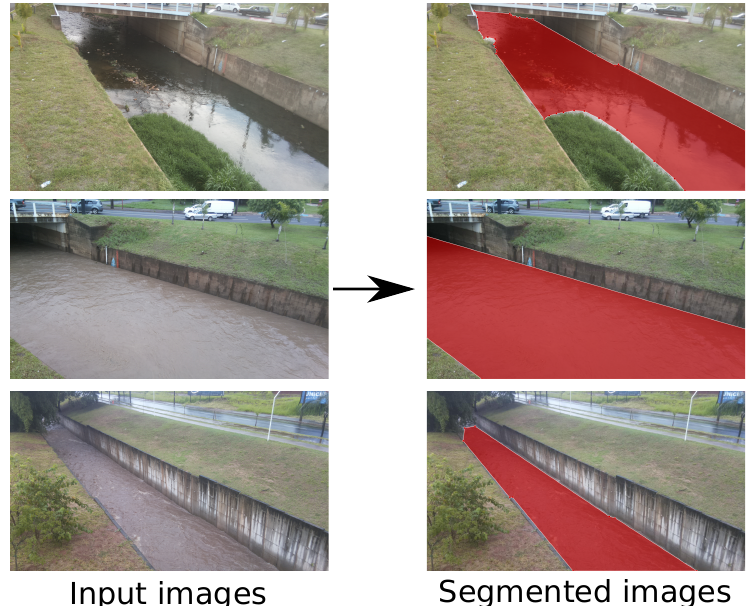
Figure 6. Sample images from our São Carlos Rivers